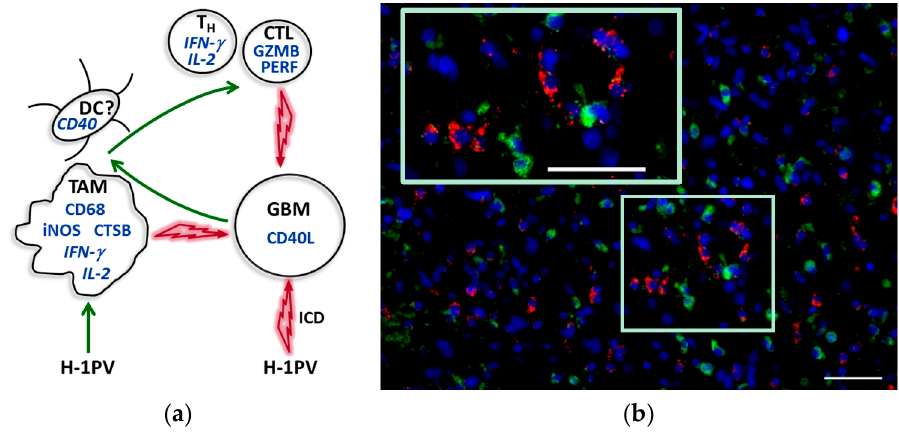
Figure 4. Central role of TAM in the immunogenic conversion of glioblastoma microenvironment upon H-1PV infection. ( a ) Tentative model based on existing (pre)clinical data. Interacting cells are presented with corresponding proinflammatory products (in italics if cellular source unproved). The identification of CD40 + myeloid cells as being denditric cells (DCs) is putative. Green and red arrows indicate activating and cytotoxic interactions, respectively. For details, see main text. T H , helper T cell; CTL, cytotoxic T lymphocyte; GZMB, granzyme B; PERF, perforin; GBM, glioblastoma; ICD, immunogenic cell death; ( b ) Activated TAM (CD68, green) in CD40L-positive (red) tumor region. Scale bars: 50 μ m.